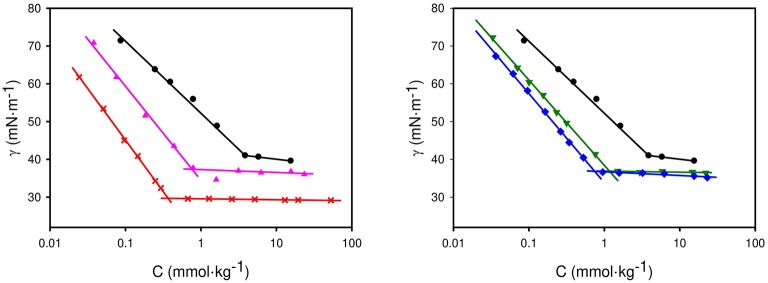
Surface tension of aqueous solutions of surfactants at 298.15 K. • Na [ONS] ,▴[C1Pyr] [ONS] ,×[C1C6Im] [ONS] ,▾[C2Py] [ONS] ,♦[C4Py] [ONS].